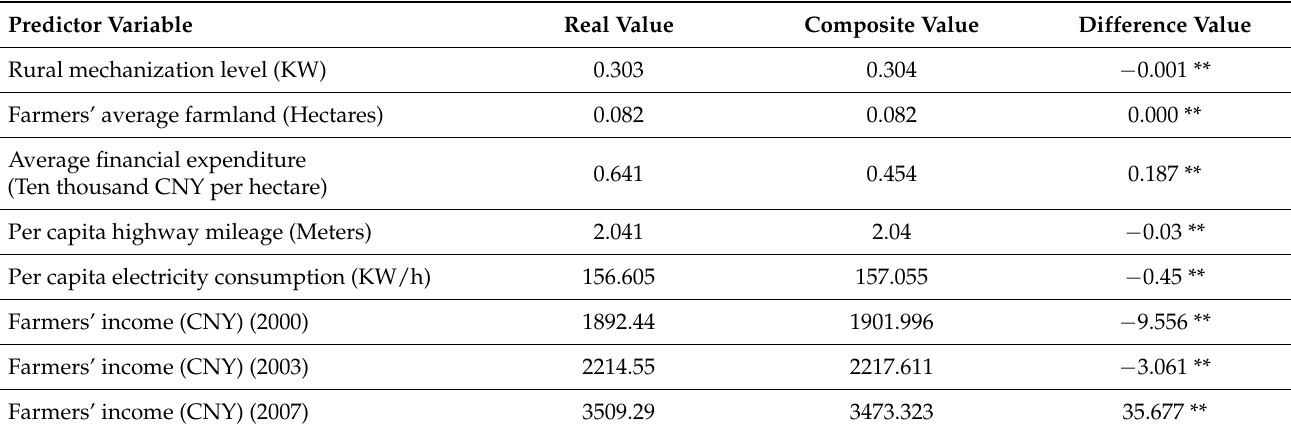
Table 3. The comparison of the true value and the synthetic value of the predictor variables.